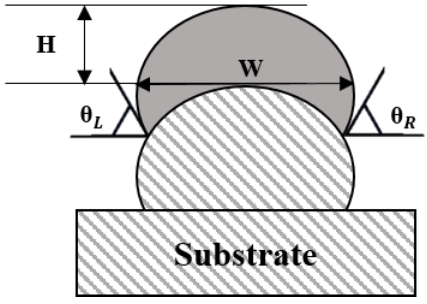
Figure 6. Schematic diagram of bead shape.